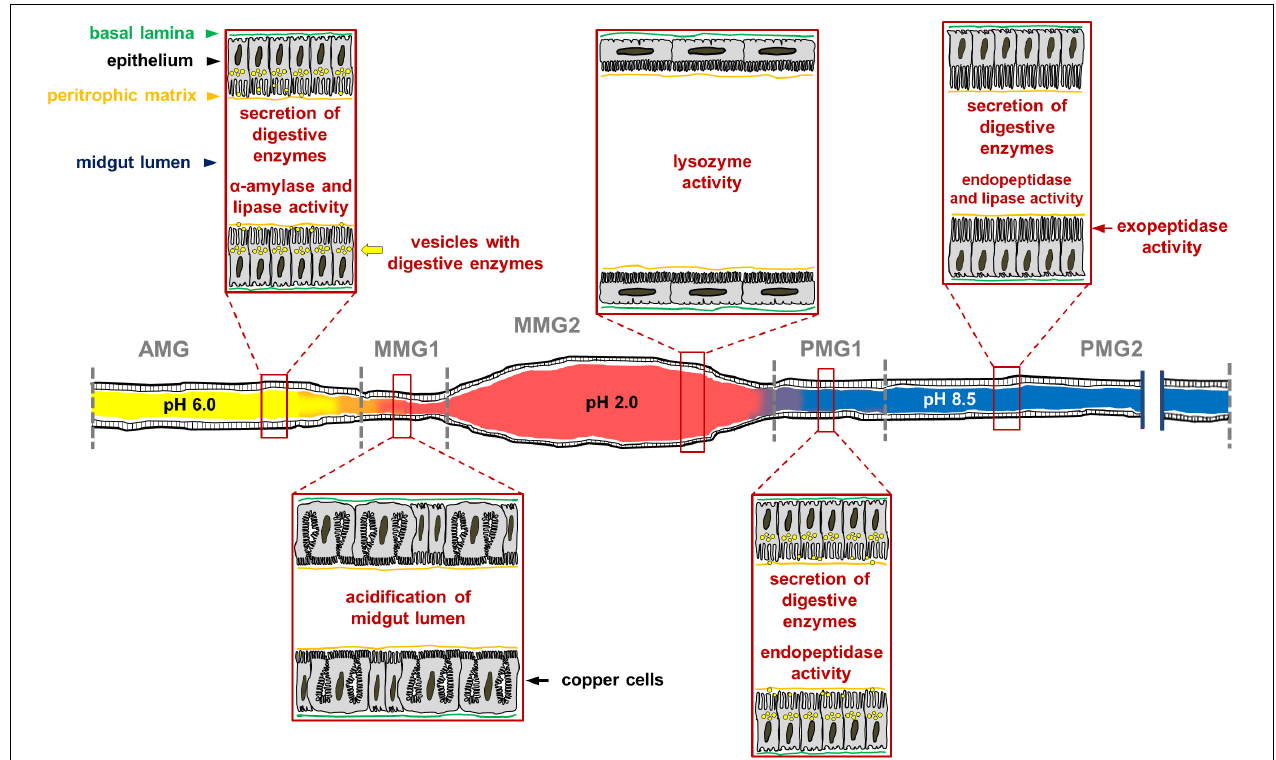
FIGURE 14 | Schematic representation of H. illucens larval midgut in which the main morphofunctional features of each region of the organ are reported. The luminal pH of the three regions is very different, being acidic, strongly acidic, and alkaline in the anterior, middle, and posterior midgut, respectively. The AMG is characterized by columnar cells with secretory activity; in this region ingested polysaccharides begin to be degraded by soluble amylases and lipids are hydrolyzed by lipase. Copper cells, which are responsible for the highly acidic pH in the luminal content of the middle midgut, are localized in the first tract of the middle midgut (MMG1). The epithelium of the second part of the middle midgut (MMG2) is formed by large, flat cells; in this tract digestive processes do not occur, but the high activity of lysozyme and the strong luminal pH indicate an important role of this region in killing ingested pathogens. The posterior region of the midgut plays a fundamental role in protein digestion thanks to endo-and eso-peptidases, and it is responsible for further digestion of lipids. The first tract of this region (PMG1) is characterized by columnar cells with secretory activity, while the second one (PMG2) presents columnar cells with microvilli that are longer than in other regions, suggesting a main role of these cells in nutrient